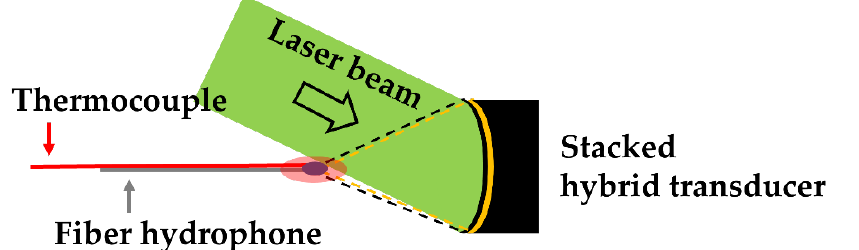
Figure 3. A schematic arrangement for dual-focused US from the stacked hybrid transducer ( θ = 0°). It is shown with the input laser beam for optoacoustic generation. The focal zone of the LGFU is shown with the small blue ellipse. The greater red ellipse indicates the focal zone of the HIFU.